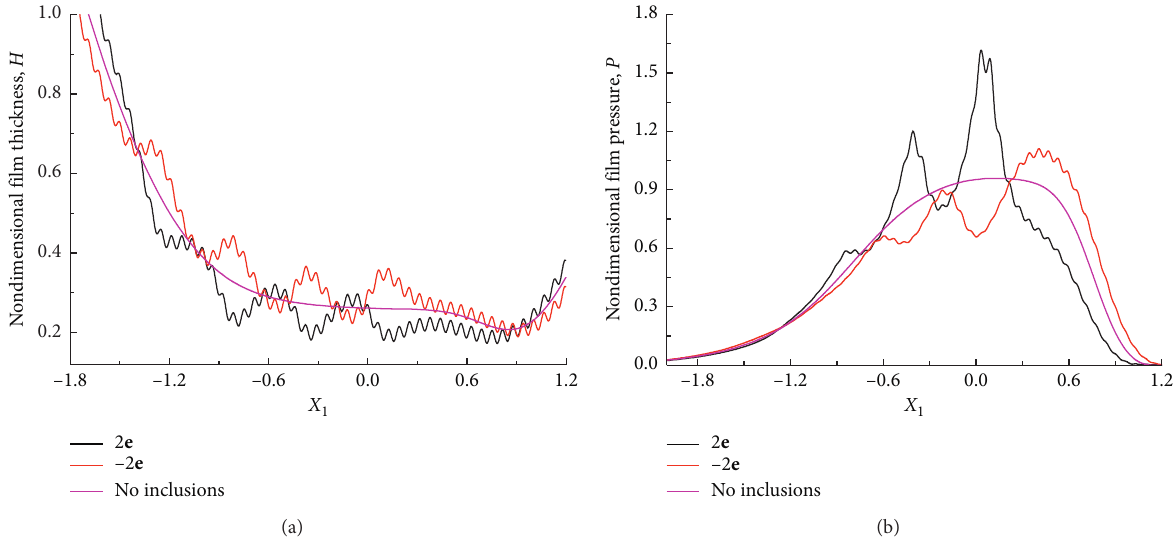
Figure 5: Nondimensional film thickness and pressure of the sinusoidal rough surface with particle eigenstrains, 2 e and − 2 e